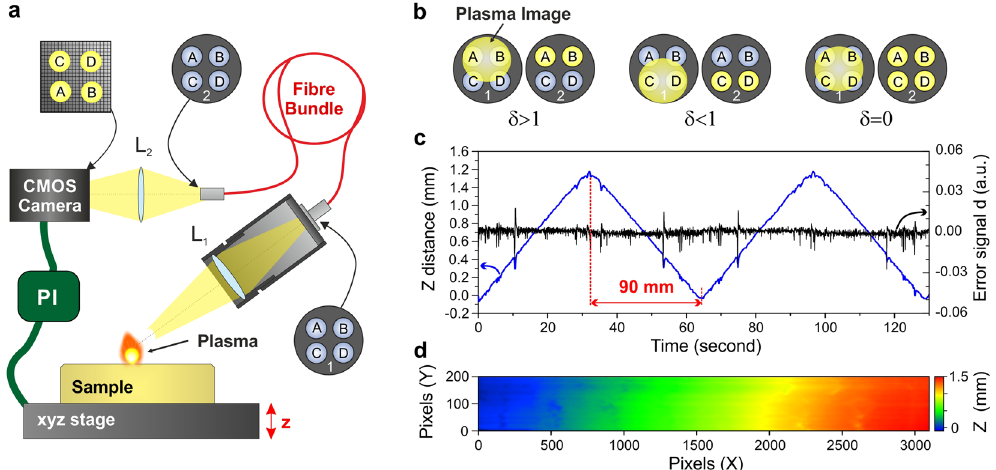
Figure 2. Autofocus system. ( a ) Schematic view of the autofocus system (PI: Proportional Integral locking servo). ( b ) Principle of the autofocus system and its influence on the error signal δ . ( c ) Vertical position of the sample (blue) and the associated error signal (black) for a 90-mm scan of the sample measured forward and backward twice. ( d ) Sample residual image showing the surface morphology and planarity of the sample during a 3100 × 200 scan (15 µ m resolution). Note that in this example, a tilt of about 1.5 mm was deliberately set in the sample positioning to show the large accessible range of the autofocus